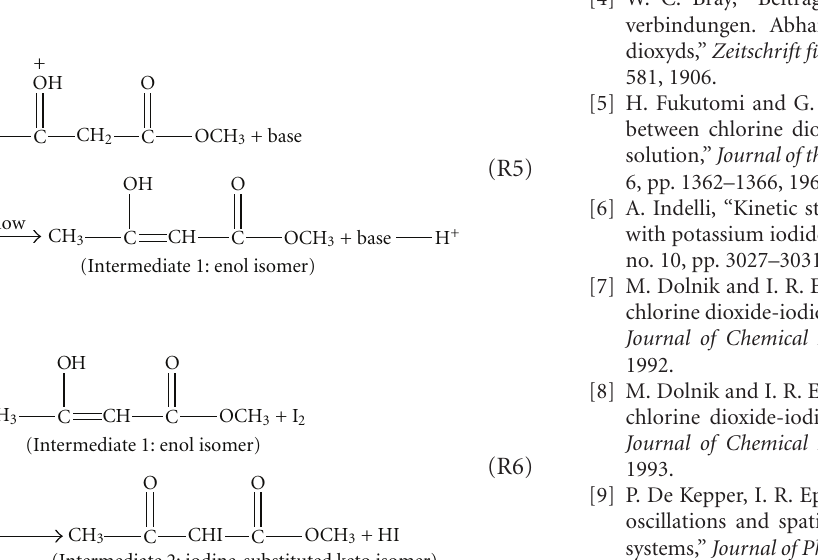
Figure 14: The curve of intermediate 2 relative concentration ver- sus reaction